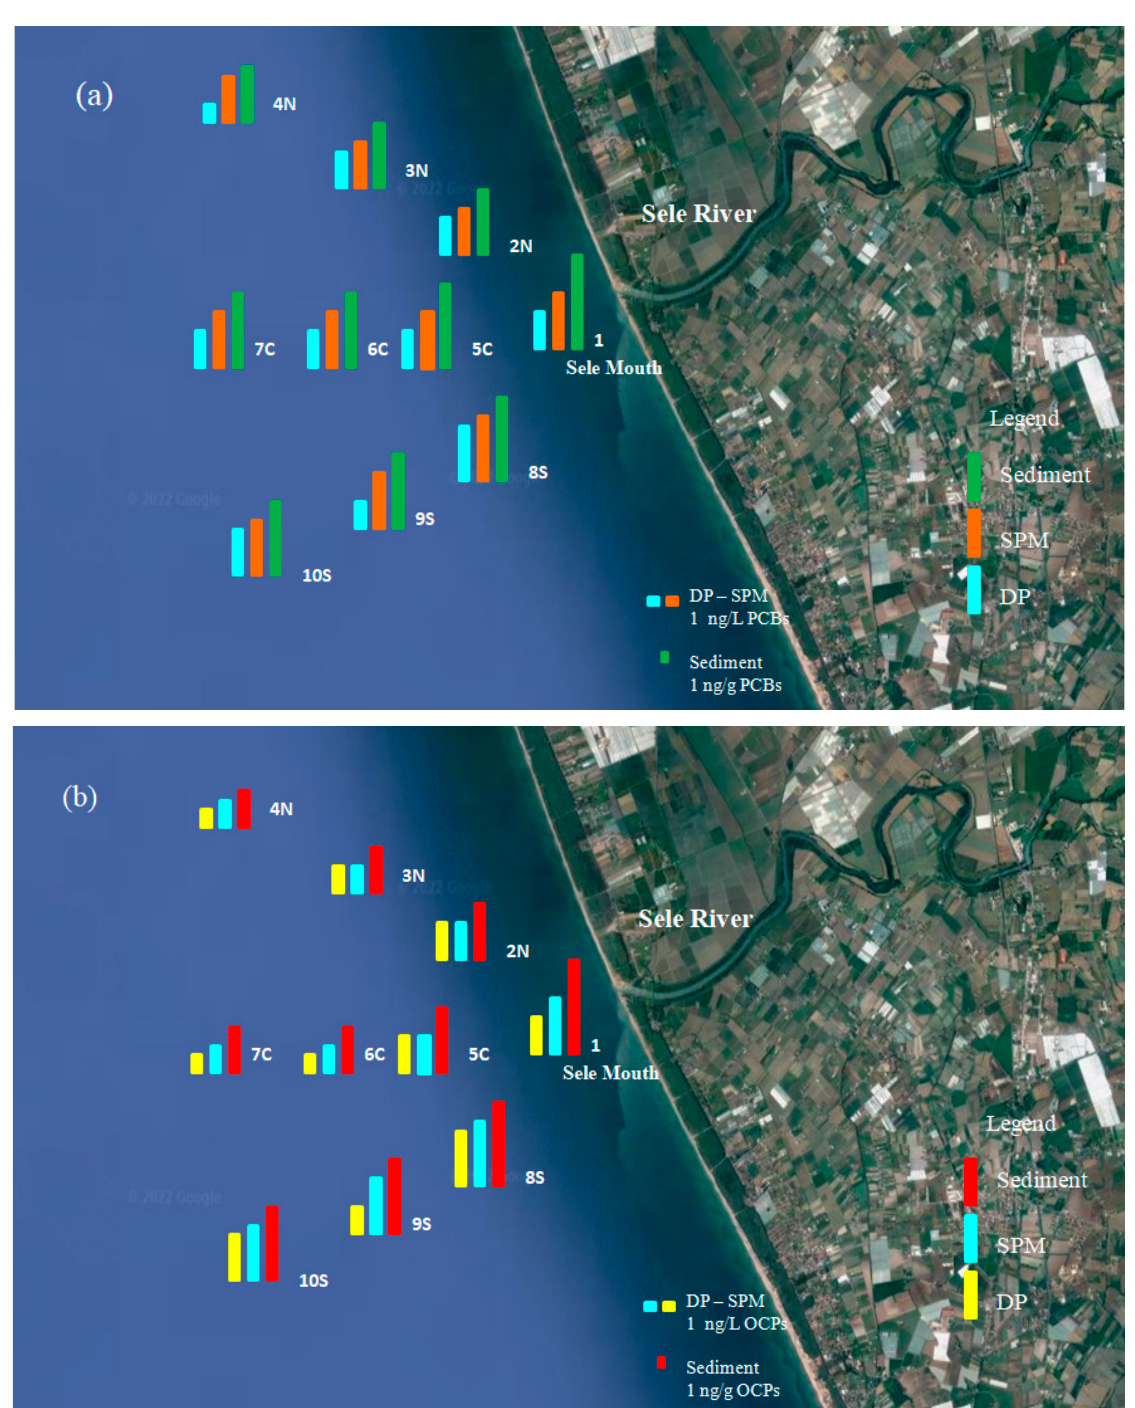
Figure 4. ( a , b ) show the spatial distribution of PCBs and OCPs in the water phase (DP ng/L), suspended particulate matter (SPM ng/L) and sediments (ng/g) from the Sele river. The Mouth of the Sele river is the most contaminated with a more elevated total con- centration of PCBs and OCPs. Concentrations decrease as you move away from the mouth up to 1500 m from the coast, where the concentrations of PCBs and OCPs are significantly lower. Figure 4a and b show that the highest concentrations have been obtained around the Sele river mouth, as the contaminants present in the aqueous phase are diluted as one moves away. In particular, the contaminants load from the Sele river mouth has been shown to move southward into the Tyrrhenian Sea. In this study, the pollutant load drained into the Tyrrhenian Sea by the Sele river was also calculated. The results show that the total estimated value is equal to 89.7 kg year − 1 (73.2 kg year − 1 of PCBs and 16.5 kg year − 1 of OCPs) In the water samples (DP phase), the total amount of pollutants was con- siderably lower mainly during the wet season (February), due to the abundant rains which caused water dilution effects. On the other hand, in SPM samples, the amounts were lowest in all sampling sites during the dry season. The results showed that the con- taminants concentrations in DP decreased from July to February, in parallel with the in- crease in rainfall, which could cause dilution ratio variations. Therefore, the decrease of the pollutants amount moving from the Sele river mouth to the Mediterranean Sea is also affected by the high flow in the rainfall season, which results in an even higher dilution ratio. The lowest concentrations in SPM were recorded in the dry season (July), due to the decrease in flow and a greater stagnation of SPM, which led to the shift of contaminants from SPM to DP. 3.4. Potential Sources of PCBs For the purpose of more accurately controlling the emission and release of PCBs, it is deemed necessity to define their contamination sources as much as possible. Principal Component Analysis (PCA) has been executed on the different sediment datasets. Six